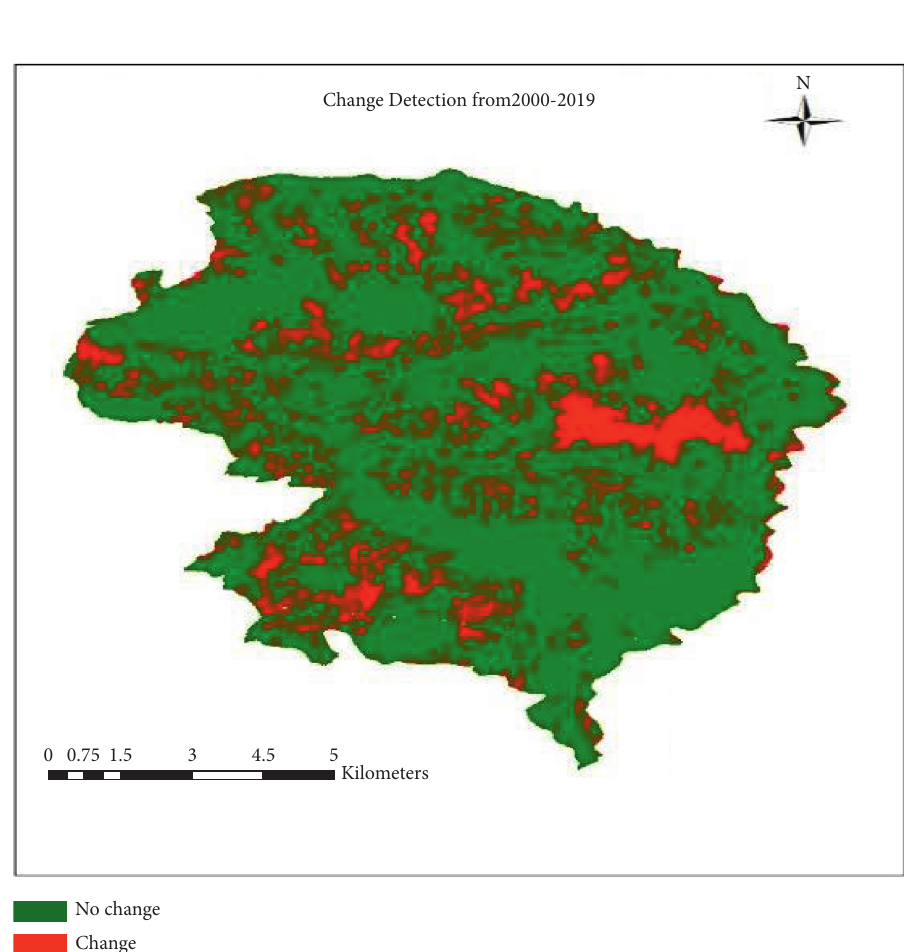
Figure 3: Land cover change detecting the migration effect in land cover.